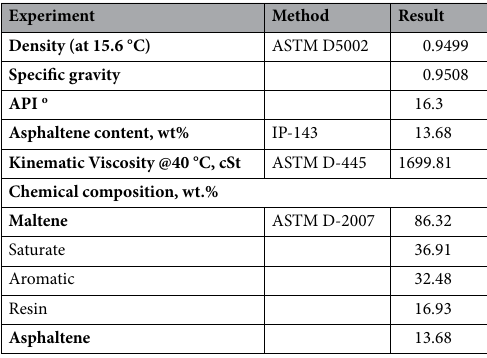
Table 1. Physico-chemical properties of crude oil 11